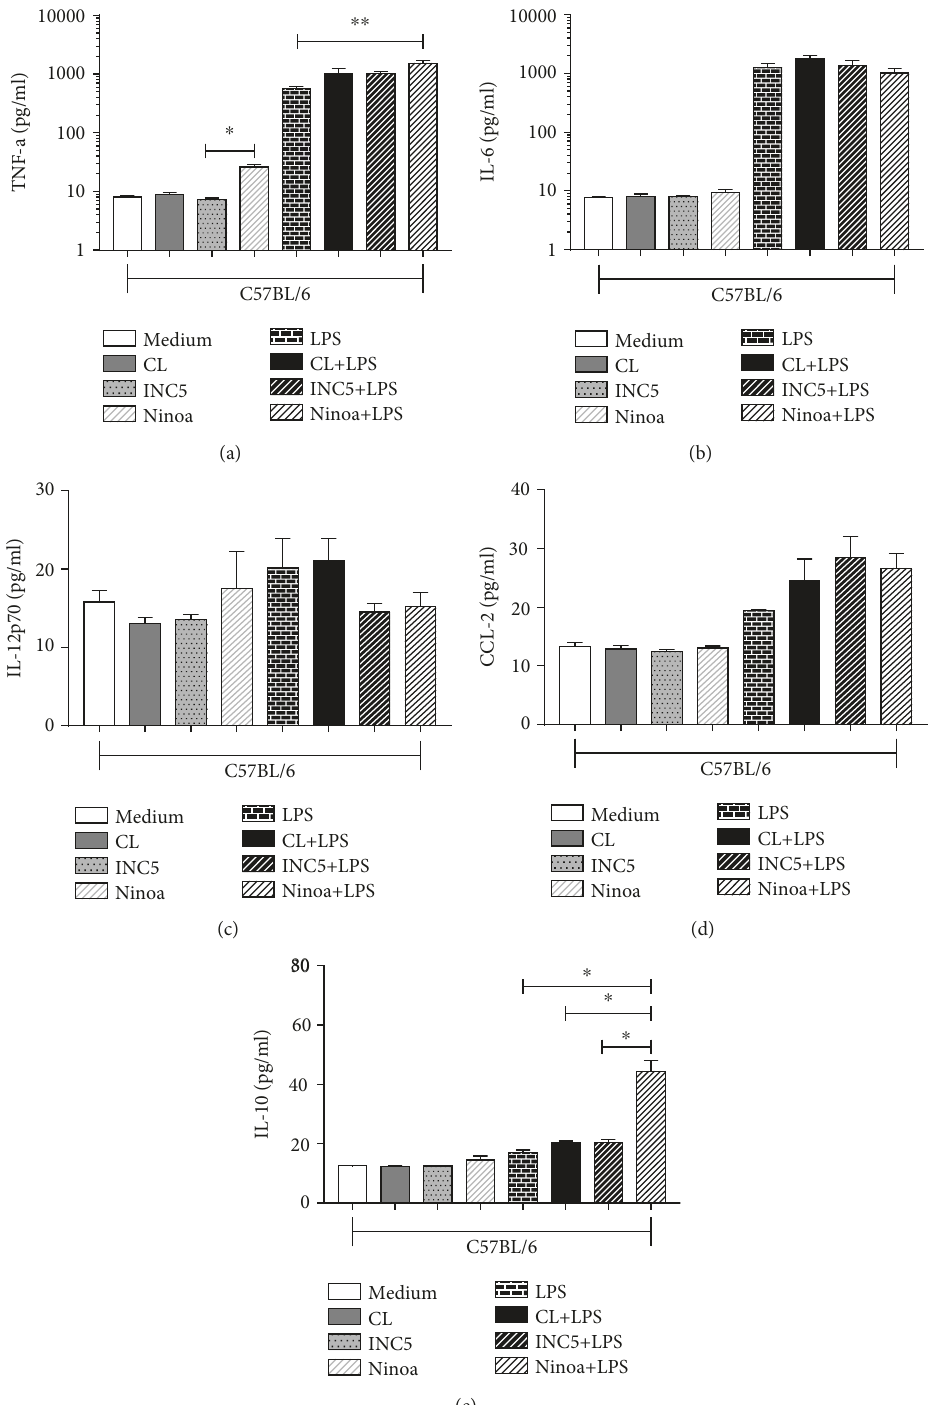
Figure 3: Cytokine and chemokine production by C57BL/6-derived BMDC infected with CL-Brener, Ninoa, and INC5 strains of T cruzi . BMDCs with or without LPS stimulation (5 μ g/mL) were incubated for 18h with di ff erent T. cruzi strains (MOI 2:1), and the production of cytokines and chemokine was evaluated by CBA: (a) TNF- α , (b) IL-6, (c) IL-12p70, (d) CCL-2, and (e) IL-10. Statistical analysis, when applicable, was performed with the Kruskal-Wallis test with Dunn ’ s posttest, where ∗ , ∗∗ p < 0 05